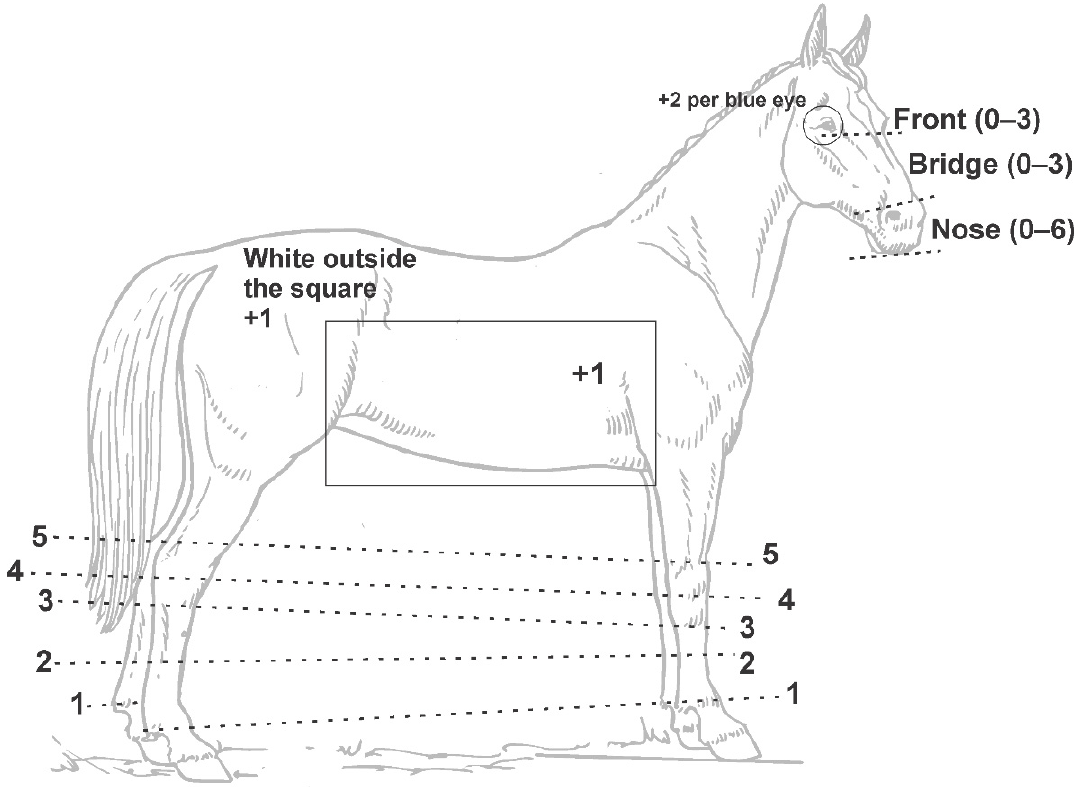
Figure 2. Average Grade of White phenotyping system as modified from that published by Rieder et al. [19]. Dashed lines demonstrate anatomical locations and limits for each score. Leg scores range from 0 (no white) to 5 (white above the respective dotted line).